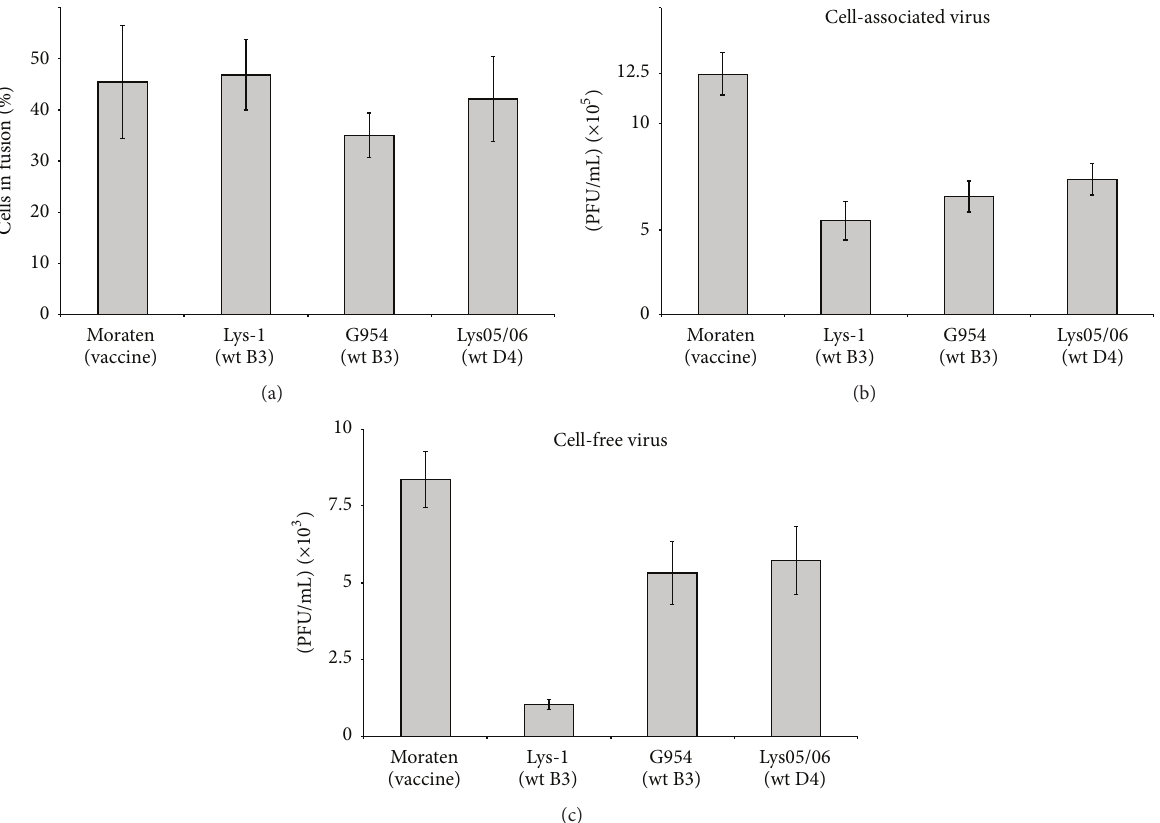
Figure 2: (a) Comparison of the cell-cell fusion capacity of Moraten (genotype A), Lys-1 (genotype B3), G954 (genotype B3), and Lys05/06 (genotype D4) strains. CHO-SLAM cells were infected with the different strains and the fusion levels analysed 30–36 h after infection. The histogram data represent the mean percentages ± standard deviations for three experiments. (b) Cell-associated virus production of the Moraten (genotype A), Lys-1 (genotype B3), G954 (genotype B3), and Lys05/06 (genotype D4) strains. CHO-SLAM cells infected with the different viruses were analysed for the production of cell-associated viral particles 48 h after infection. The histogram data represent the mean percentages ± standard deviations for three experiments. (c) Cell-free virus production of the Moraten (genotype A), Lys-1 (genotype B3), G954 (genotype B3), and Lys05/06 (genotype D4) strains. CHO-SLAM cells infected with the different viruses were analysed for the production of cell-free viral particles 48 h after infection. The histogram data represent the mean percentages ± standard deviations for three